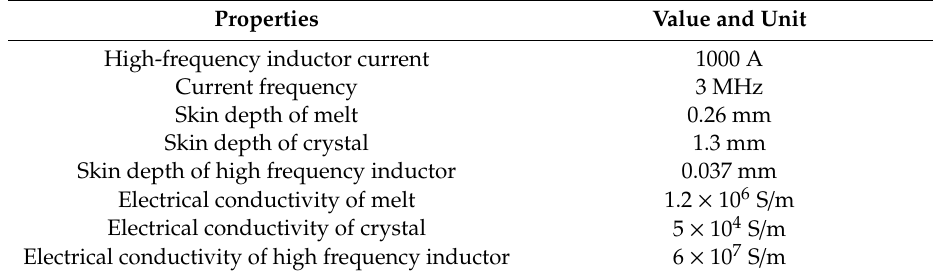
Table 1. Physical properties and calculation conditions in the high-frequency EM model.